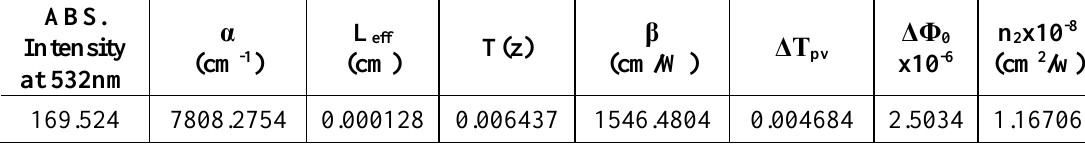
Figure 10: Close aperture Z-scan measurements of Vitamin D -5000IU soft gel. 3 -5000IU soft 3